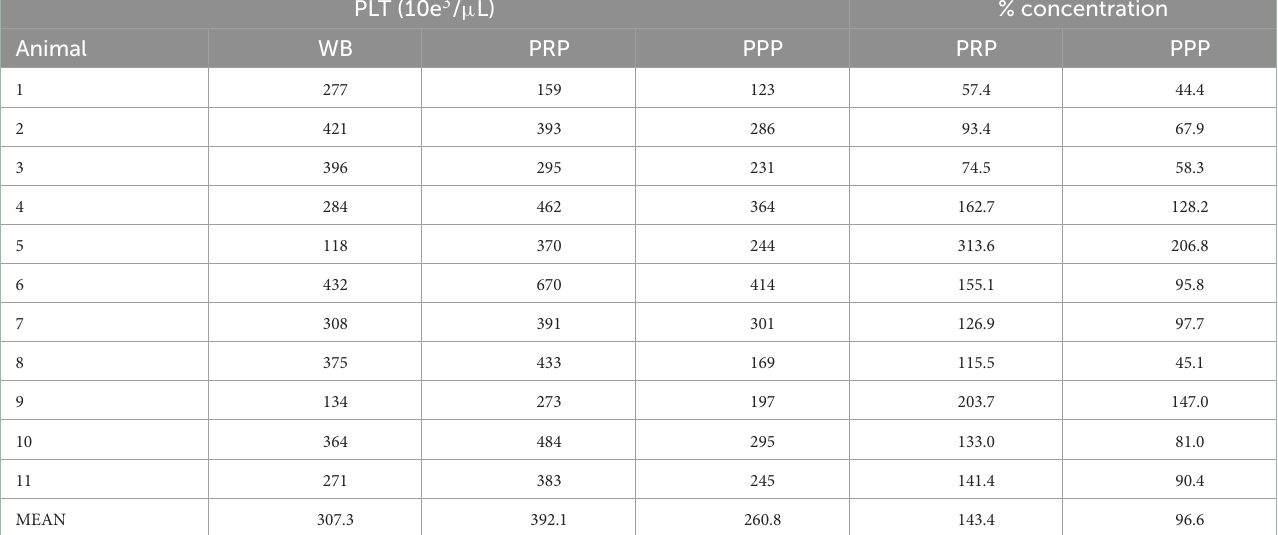
TABLE 3 Number of platelets (PLT) in whole blood (WB) and platelet concentrations considering the total volumes of plasma in the PRP and PPP fractions.